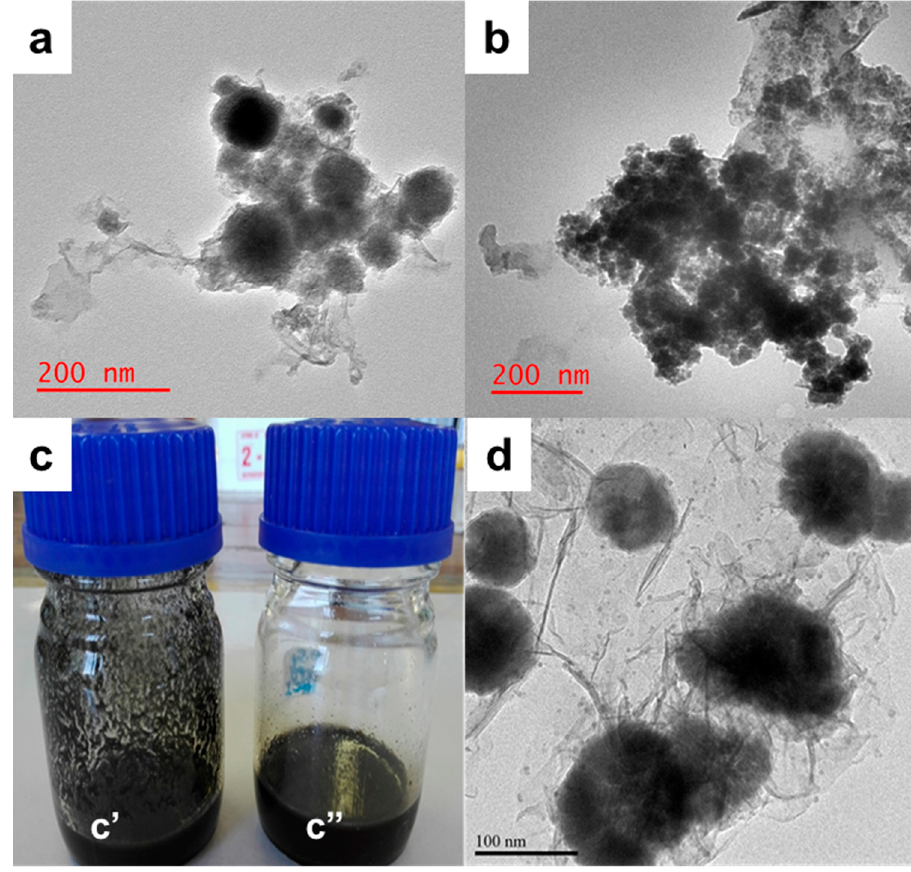
Figure 4. HR-TEM of ( a ) Pd@Fe@HPEI and ( b ) Pd@FeAg@HPEI, ( c ) The effect of HPEI on the dispersion of nanoparticles, where ( c’ ) and ( c” ) are the respective Pd@Fe@PMAA-PES